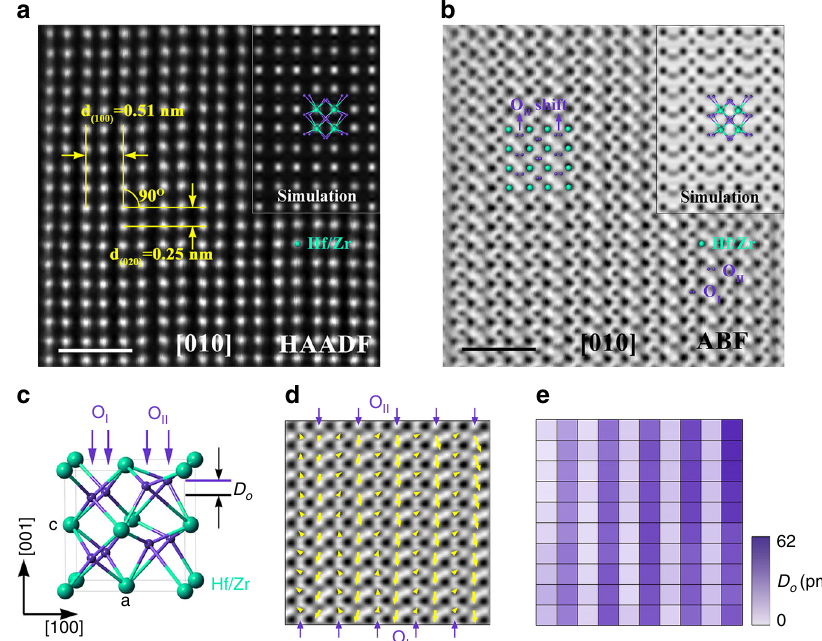
Fig. 2 Atomic structure of HZO orthorhombic phase. a Scanning transmission electron microscopy high-angle annular dark- fi eld (STEM-HAADF) image of the HZO grain projected along O [010] zone axes with the inset of simulated HAADF picture. Scale bar, 1nm. b The corresponding scanning transmission electron microscopy high-angle annular dark- fi eld annular bright- fi eld (STEM-ABF) image of ( a ) with the inset of simulated ABF picture. Scale bar, 1nm. c Schematic of the unit cell of HZO, where D O denotes the relative displacement of O atoms. d O atomic displacement vector map from the area in ( b ). The yellow arrows indicate reversed O atom displacement ( D O ) vectors, which were consistent with the spontaneous polarization direction in ( b ). e Two- dimensional O atomic displacement map relative to the central positions of the four nearest heavy atoms, which corresponds to the yellow arrows in ( d